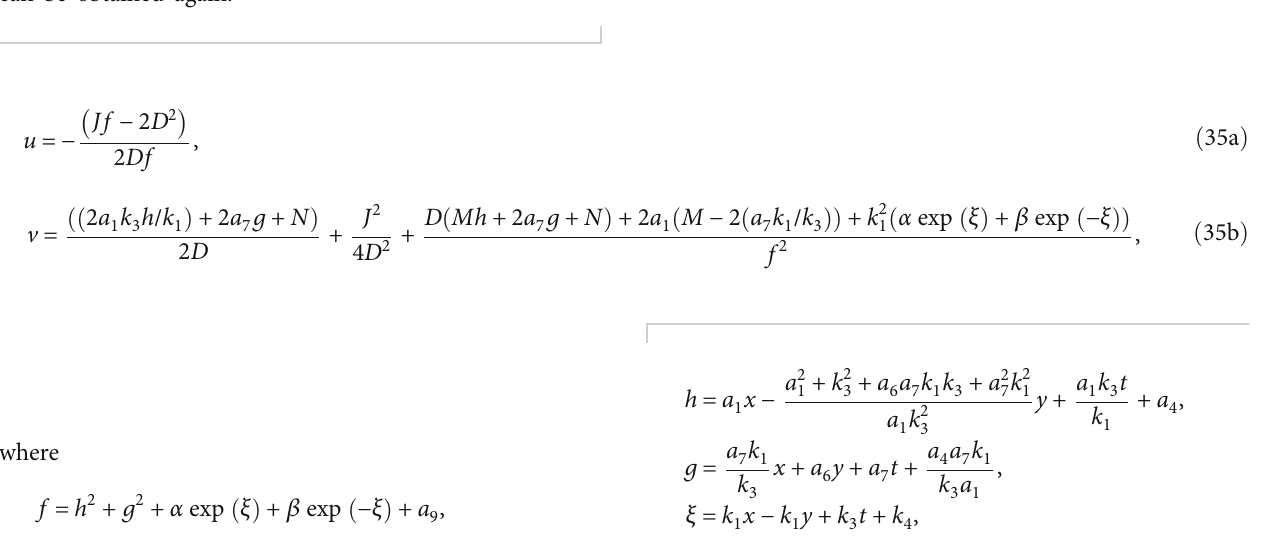
= 2 , k = 1 , and k = 0 . (a) 3-dimensional plot 2 3 4